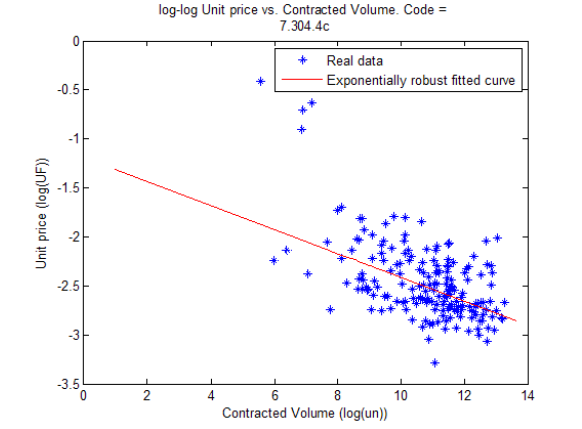
Fig. 3. Logarithmic space transformation